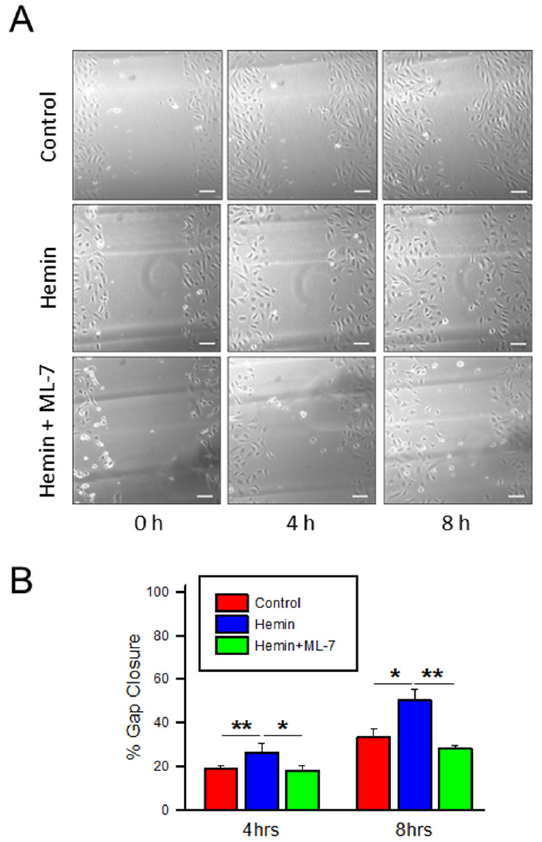
Figure 6. Hemin increases HPAEC migration, which is prevented by MLCK inhibition as measured by scratch wound healing assay. ( A ) Representative images of a wound healing (scratch) assay. A scratch was created in a confluent culture of HPAECs and images of wound were obtained at 0, 4, and 8 h after treatment with hemin (5 µ M), PBS control, and hemin pre-treated with ML-7 (20 µ M). Scale bar, 100 µ m. ( B ) Bar graph denoting scratch assay gap closure at given time points ( n = 6 for control and hemin, 4 for hemin + ML-7) * indicates p < 0.05; **, p < 0.01; ML-7, myosin light chain kinase specific inhibitor.